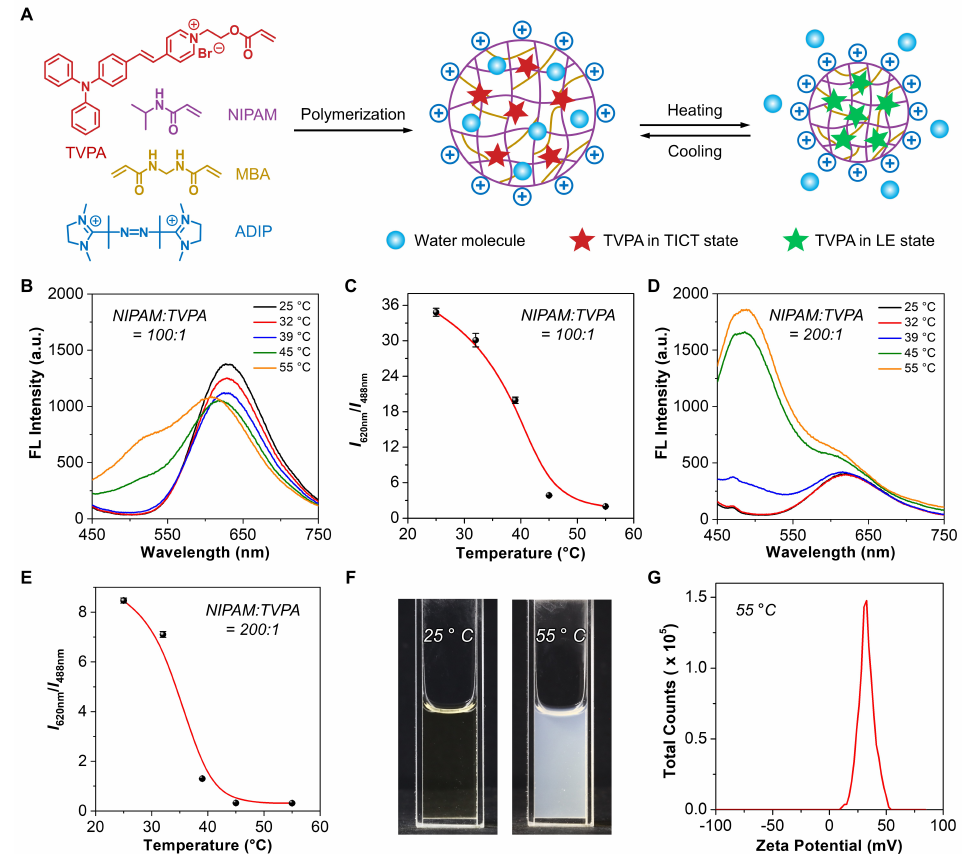
Figure 2. Fabrication of nanogels with different molar ratios of NIPAM and TVPA. ( A ) Schematic illustration showing the polymerization process and thermoresponsive behaviors. ( B ) Temperature- dependent emission spectra of the nanogel (NIPAM:TVPA = 100:1, 0.25 mg mL − 1 ). Ex = 405 nm. ( C ) Changes in the ratio of the emission intensities at 620 and 488 nm from panel ( B ) as a function of temperature ( n = 3). ( D ) Temperature-dependent emission spectra of the nanogel (NIPAM:TVPA = 200:1, 0.25 mg mL − 1 ). Ex = 405 nm. ( E ) Changes in the ratio of the emission intensities at 620 and 488 nm from panel ( D ) as a function of temperature ( n = 3). ( F ) Photographs of the nanogel (NIPAM:TVPA = 200:1, 2 mg mL − 1 ) at 25 and 55 ◦ C, respectively. ( G ) Plot of the zeta potential of the nanogel (NIPAM:TVPA = 200:1, 0.25 mg mL − 1 ) at 55 ◦